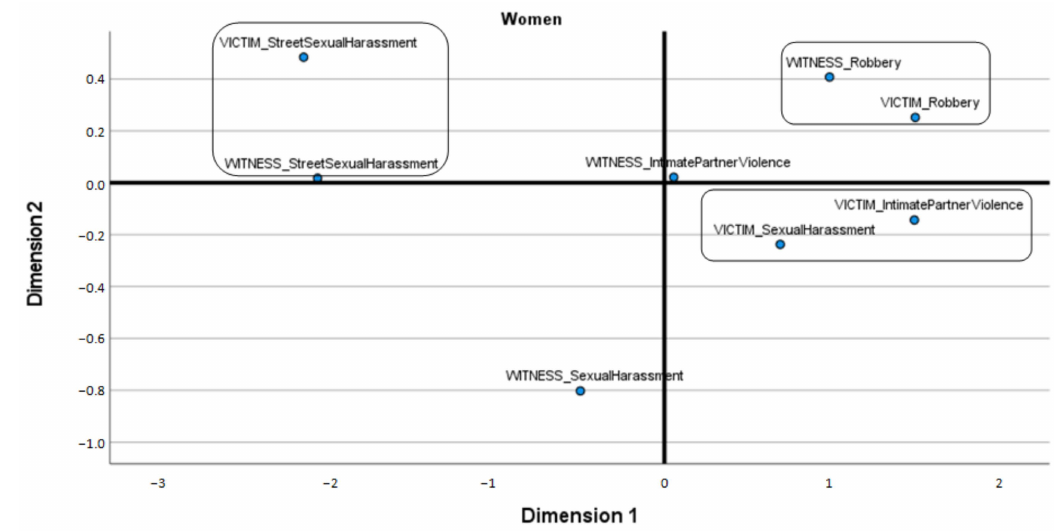
Figure 1. Multidimensional scaling of victimization types in women.